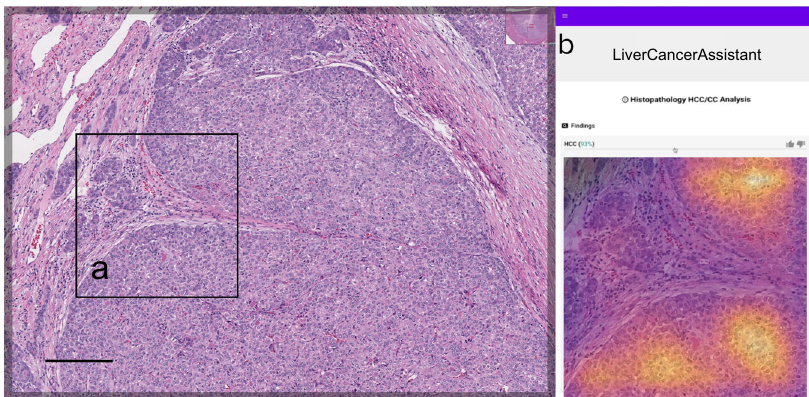
Fig. 1 Graphical user interfaces for the experiment. The pathologists navigated the slide using the ObjectiveView image viewer. After identifying a tumor region of interest (ROI), they saved a 500 × 500 μ m image patch at ×10 objective magni fi cation ( a ) containing the ROI using the ‘ crop ’ tool. (The horizonal scale bar denotes 200 μ m). After uploading the image patch to the diagnostic assistant ’ s user interface ( b ), they received a probability of each diagnosis (here, HCC), with an accompanying class activation map to assist with